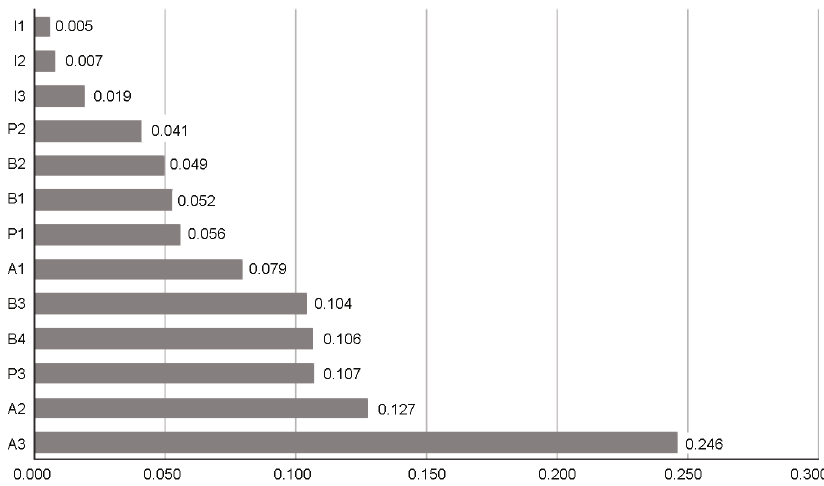
Figure 5. Priority of the factors influencing the development of trust for